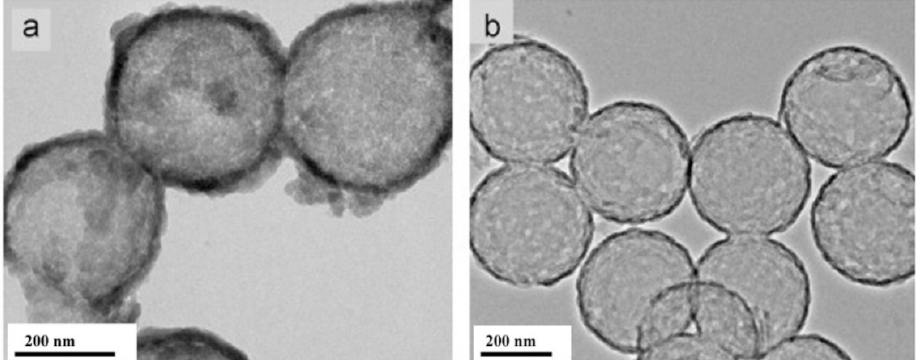
Figure 9. TEM images of the hollow SiO 2 samples, prepared by removing the latex templates from SiO 2 –coated PS–methyl acrylic acid latex composites by calcination. The SiO 2 –coated latex composites were prepared ( a ) at room temperature and aged ( b ) at 150 ◦ C. Reproduced from [75] with permission from the